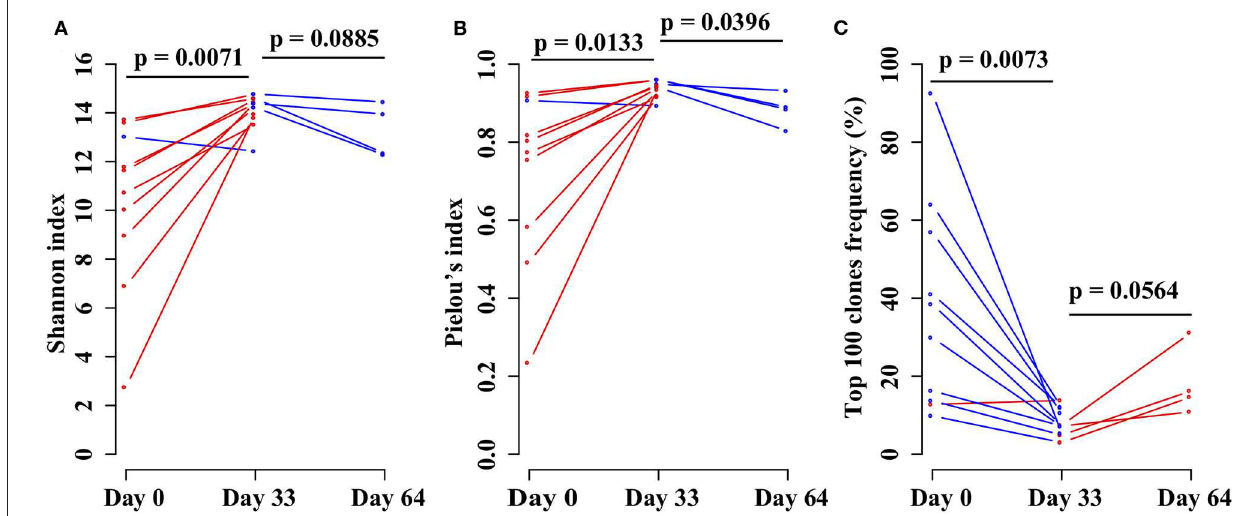
FIGURE 4 | Comparing the (A) Shannon index, (B) Pielou’s index, and (C) percentage of top 100 maximal frequency clonotypes among three different time points of the same B-ALL patients. The three time points were before chemotherapy and 33 and 64 days after chemotherapy. P -value was calculated by two-sided paired t -test.